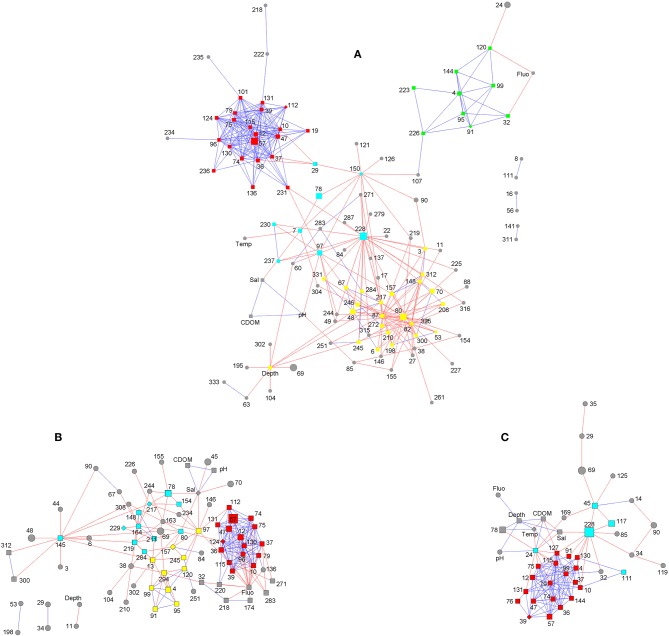
Network analysis of bacterial community in sediments of the Ross Sea. (A), in all 13 sediments; (B), in inshore sediments; (C), in offshore sediments. Red line, negative interaction; blue line, positive interaction; square, clustered OTUs; diamond, seed OTUs; circular, unclustered OTUs; OTUs with the same color constitute a module generated by clustering algorithm.